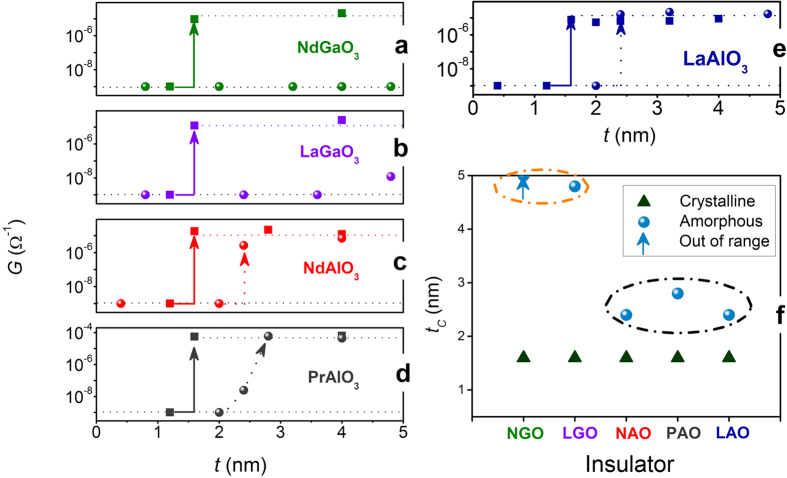
Thickness dependent conductance of crystalline (solid squares) and amorphous (solid spheres) ABO3/STO where ABO3 includes (a) NdGaO3, (b) LaGaO3, (c) NdAlO3, (d) PrAlO3 and (e) LaAlO3.Crystalline ABO3/STO show universal critical thickness of 4 uc while critical thickness of amorphous ABO3/STO is dependent on B-site atoms, as shown in (f). The solid arrow represents the metal insulator transition for crystalline interfaces while dashed arrow for amorphous interfaces transition. Dash lines are given as guides to the eye.